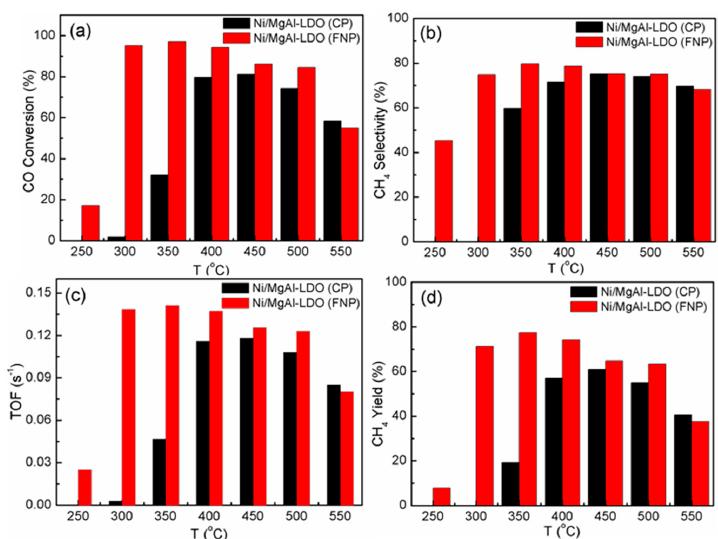
Figure 1. ( a ) Carbon monoxide (CO) conversion; ( b ) methane (CH 4 ) selectivity values; ( c ) turnover frequency (TOF) values; ( d ) CH 4 yield of the as-obtained Ni/MgAl-LDO co-precipitation (CP) and